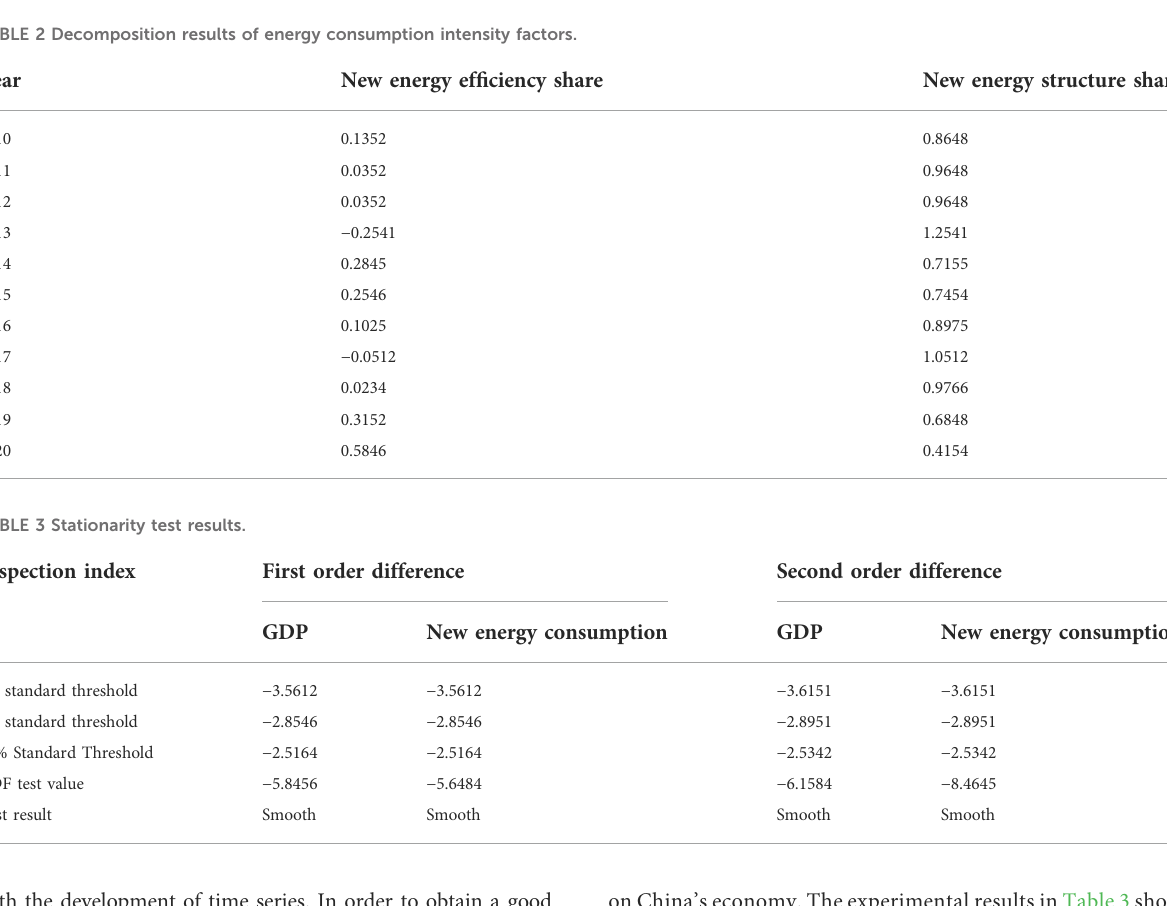
TABLE 2 Decomposition results of energy consumption intensity factors.